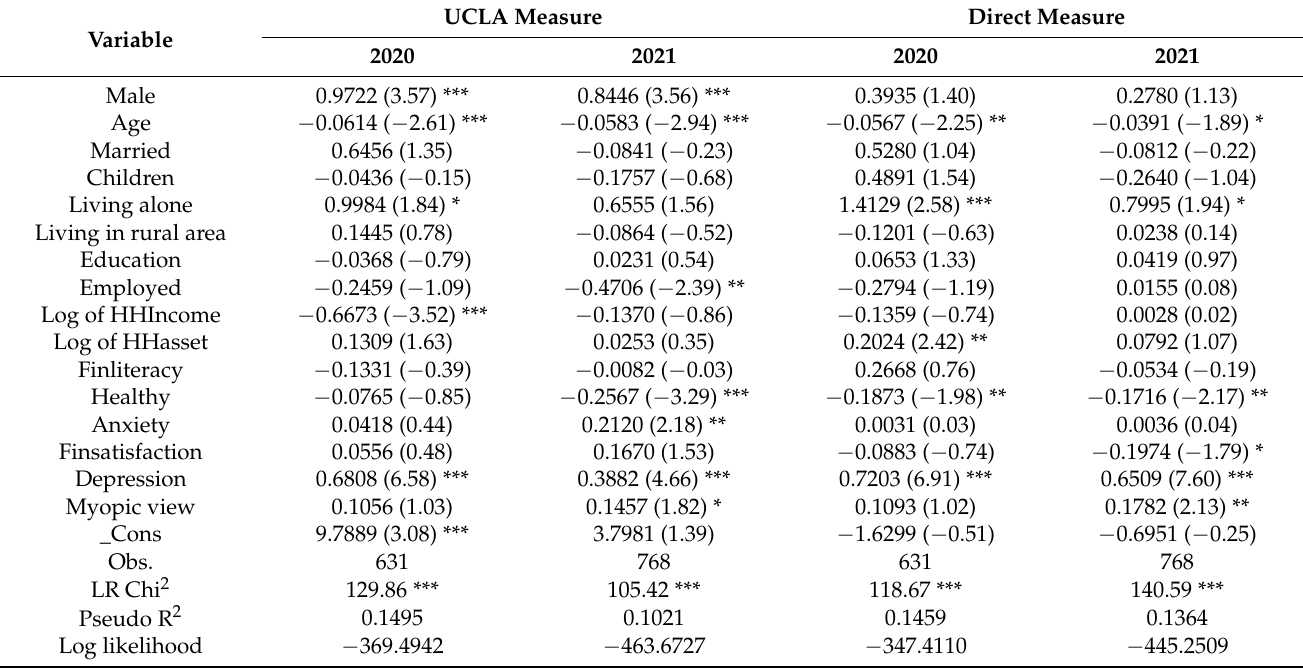
Table 5. Logit regression analysis for loneliness before and during the COVID-19 pandemic for the older sub-sample. UCLA Variable